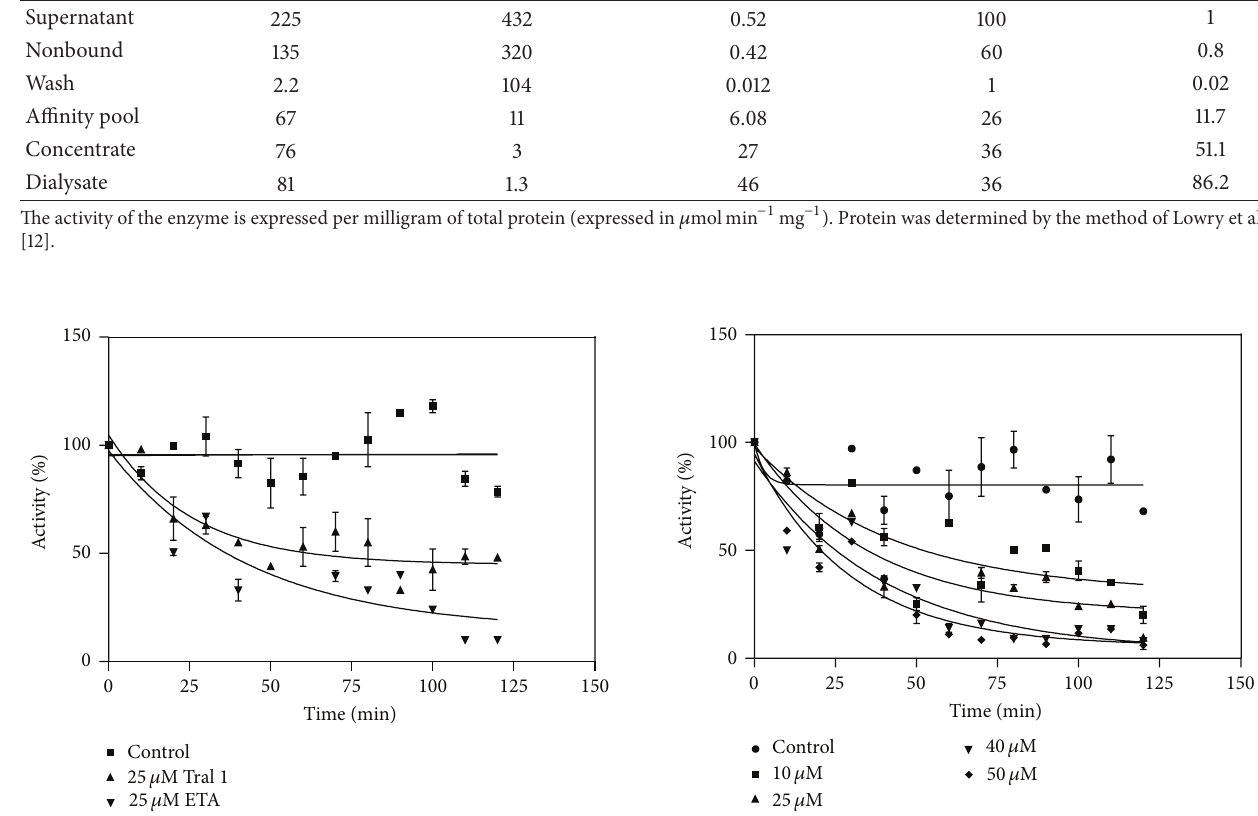
Figure 4: Percentage activity against time for the concentration- dependent inactivation of GST 𝜀 2 by Tral 1. The activity was deter- mined every 15min over a 2 h period. The 𝑡 1/2 was determined by nonlinear regression.